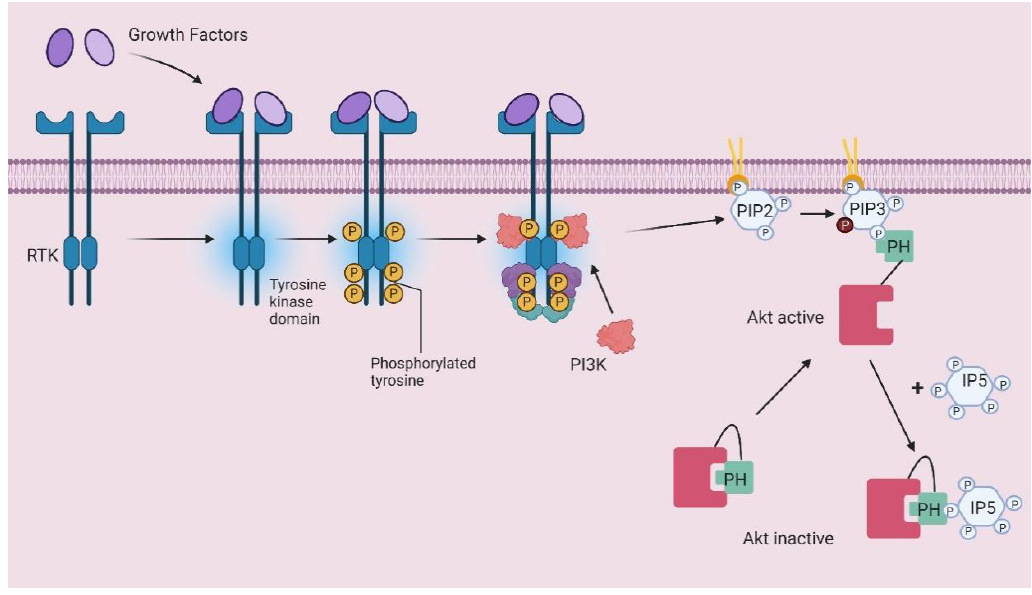
Figure 4. Schematic representation of PIP3-dependent Akt translocation and Ins P 5 competition mechanism. RTK, receptor tyrosine kinase; PIP2, PtdIns(4,5) P 2 ; PIP3, PtdIns(3,4,5) P 3 ; PI3K, Phosphoinositide 3-kinase; IP5, inositol pentakisphosphate; PH pleckstrin homology domain.